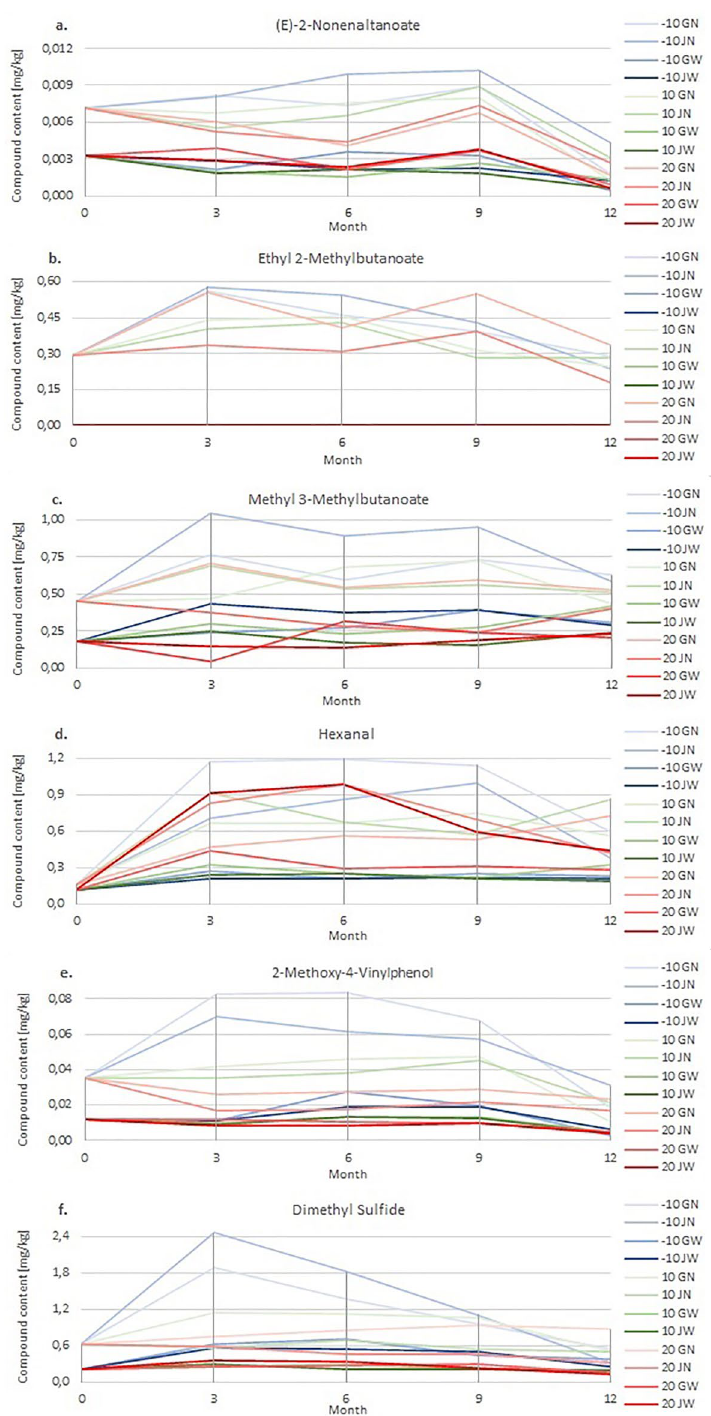
Figure 6. Diagram of average water activity analysed in tested green coffee samples on a 12-month basis (with results recorded every 3 months), after appropriate